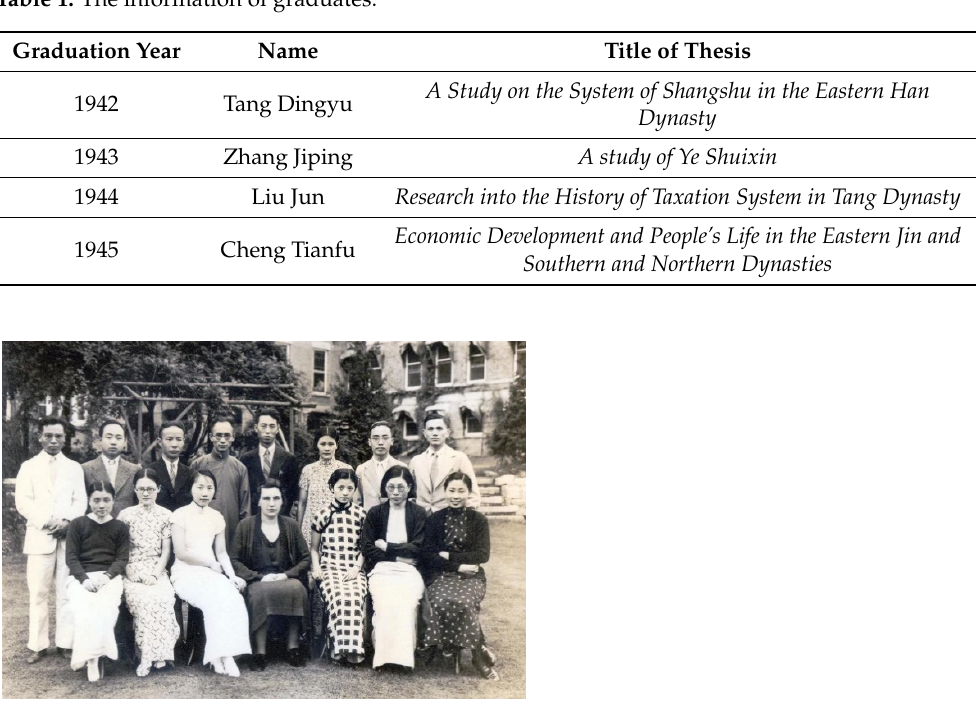
Figure 5. A Group Photo of Teachers and Students of the University of Nanking in 1937. Table 1. The information of graduates.